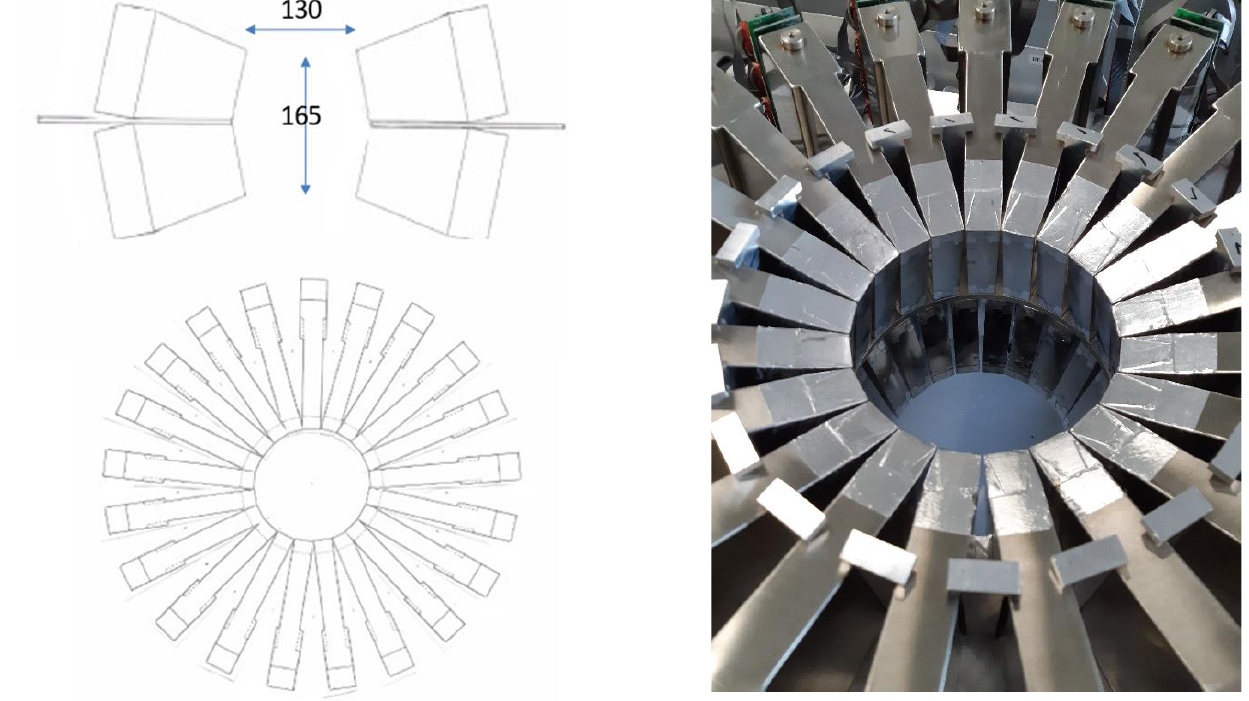
Figure 4. MicroPEPT geometry: the 42 cassettes are mounted in two rings, above and below the central mounting plate, with the detectors in the upper ring staggered relative to those in the lower ring.